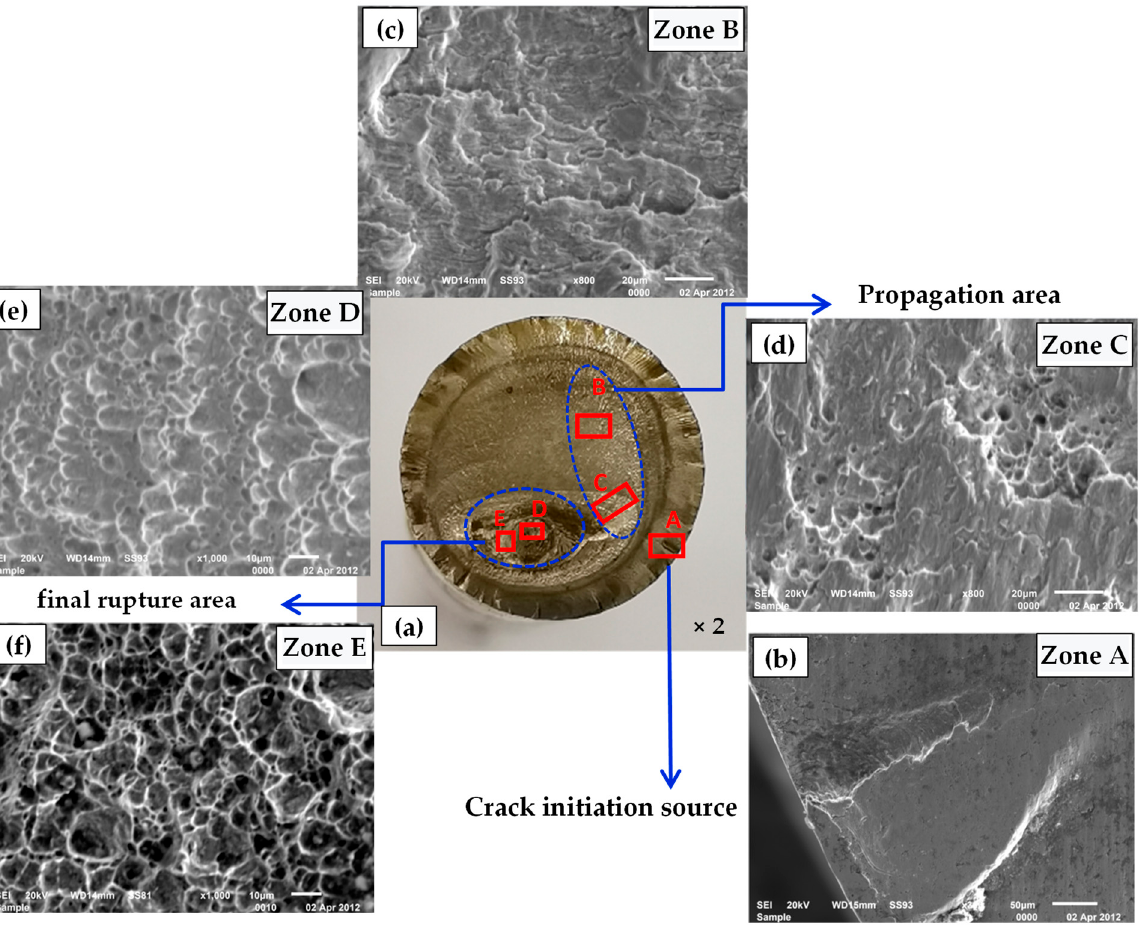
Figure 5. SEM images of the fracture surface. ( a ) SEM observation locations of the fracture. ( b ) Fracture pa tt ern of area A at the crack source (300×). ( c ) Fracture pa tt ern of B crack propagation area (800×). ( d ) Fracture pa tt ern of C crack propagation area 5 (800×). ( e ) Fracture pa tt ern of D fi nal fracture area (1000×). ( f ) Fracture pa tt ern of E fi nal rupture area (1000×).